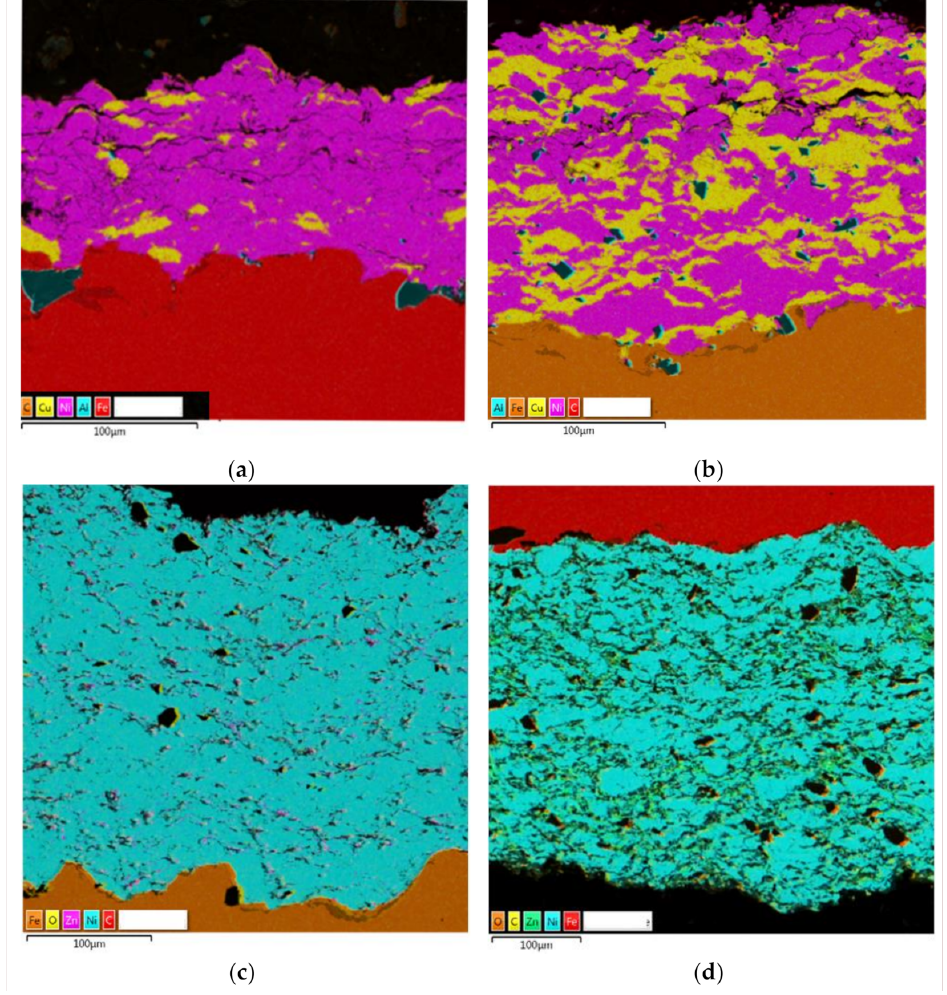
Figure 6. Ni-Zn and Ni-Cu-coatings: ( a ) Ni90-Cu10; ( b ) Ni60-Cu40; ( c ) Ni90-Zn10; ( d )